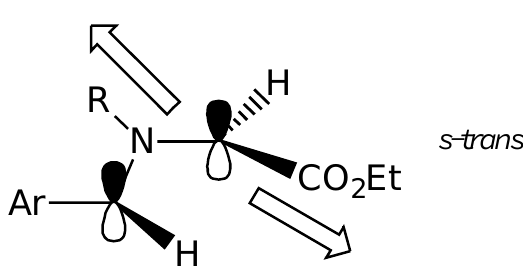
Figure 2 . Preferred geometry of the